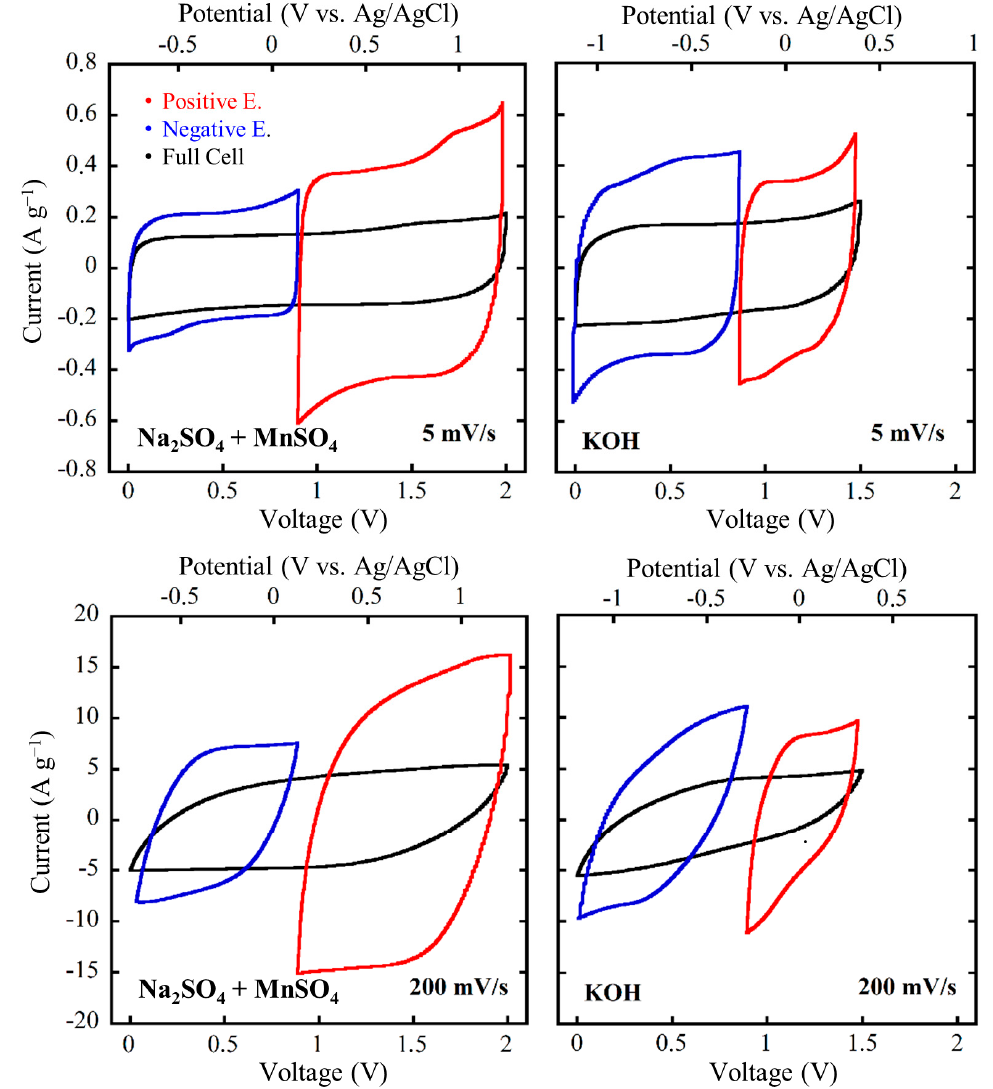
Figure 8. Separate performance in CVs of the positive and negative electrodes, and full cells in both electrolytes at 5 and 200 mV s − 1 .